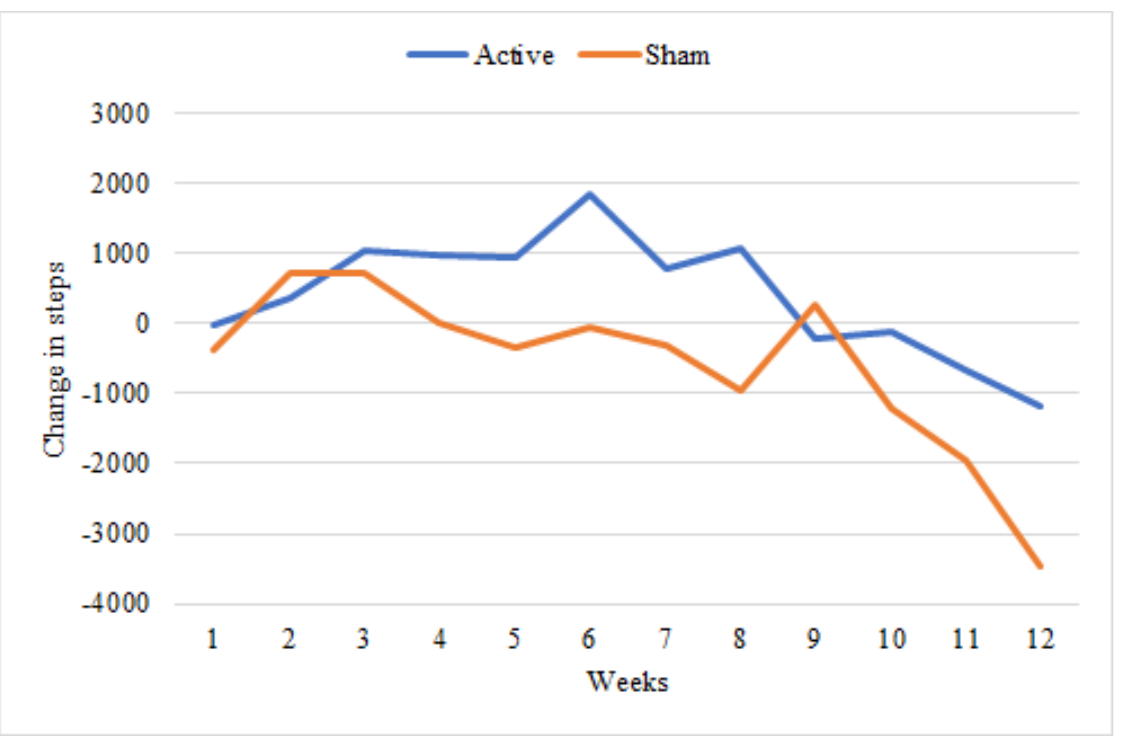
Figure 3. Weekly mean change in number of daily steps.